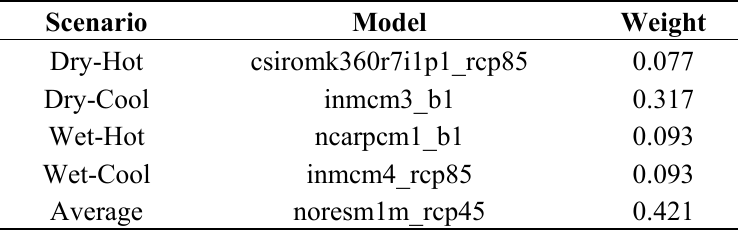
Table 6. Representative climate change